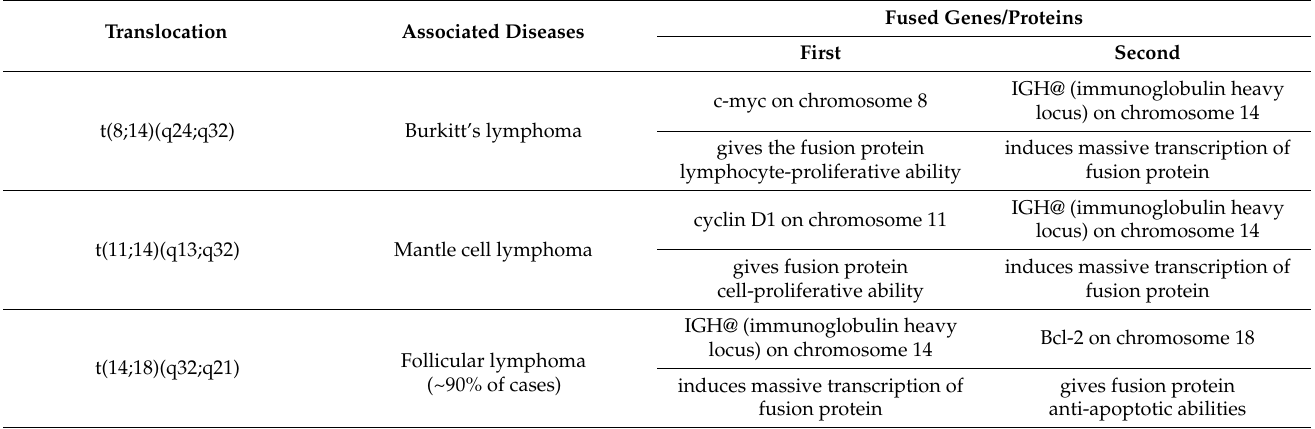
Table A1. Examples of main chromosomal translocations associated to different cancers.